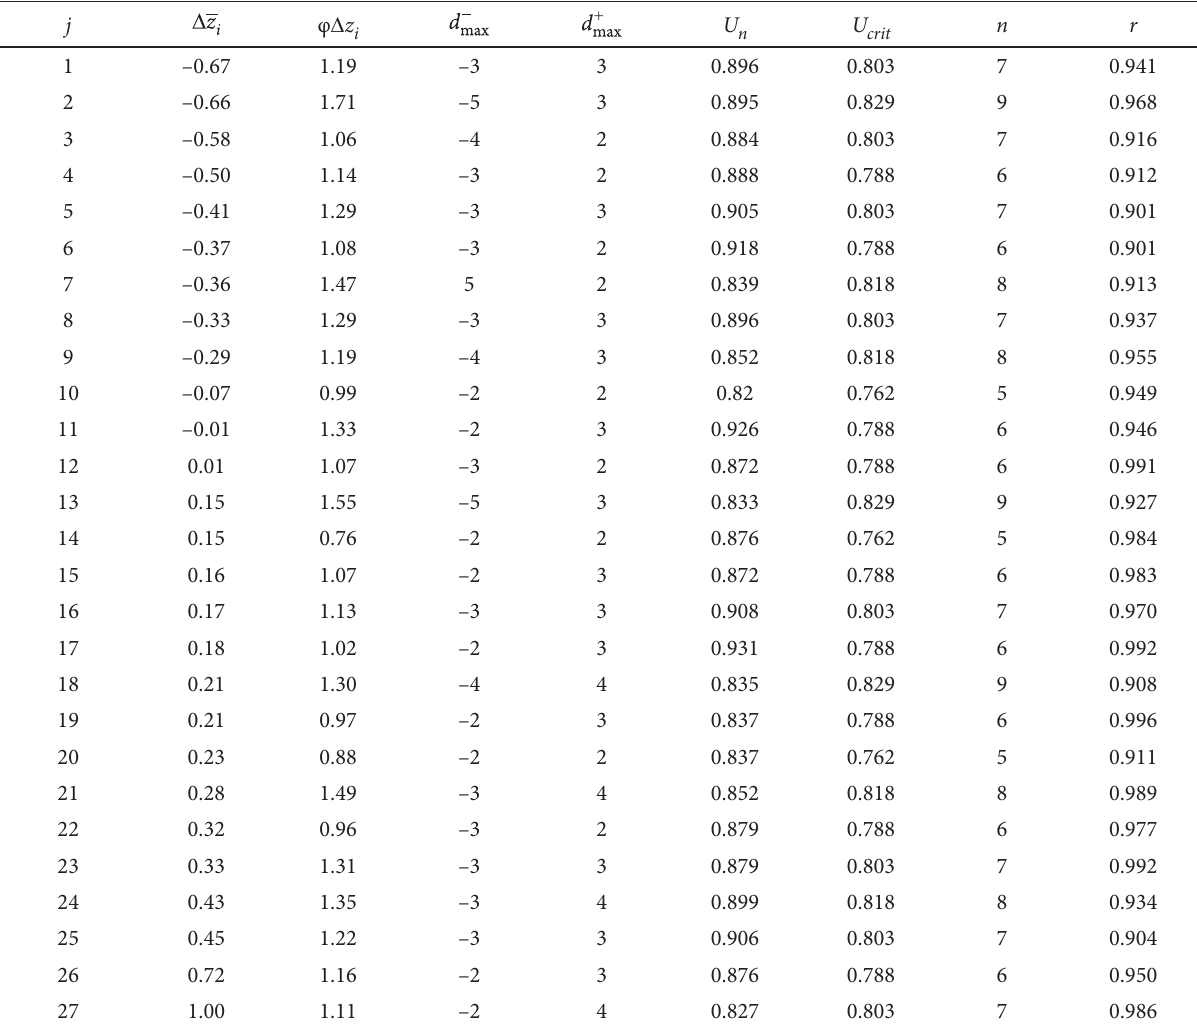
Fig. 6. Differences of two measurements methods in a sample of measurement cross section Table 1. The results of analysis of the 27 selected measurement cross sections in the collinear type of